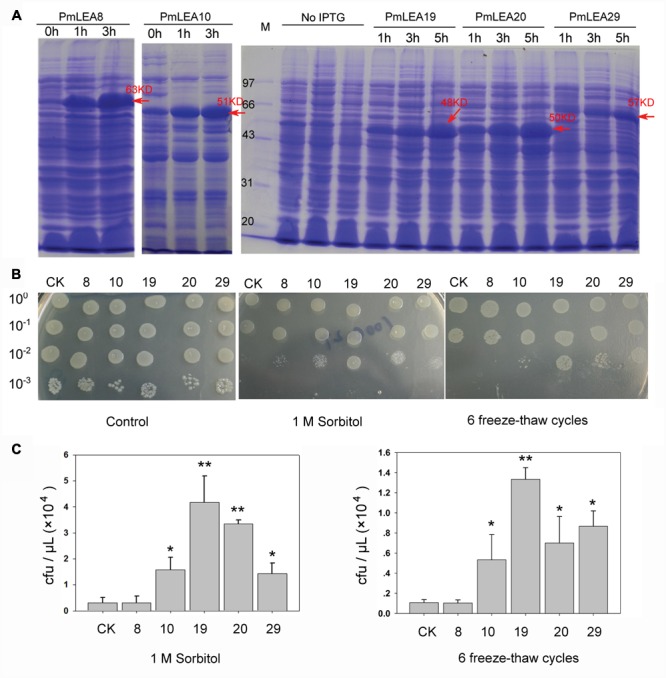
The prokaryotic expression of proteins PmLEAs and growth performance of E.coli under sorbitol or freeze-thaw cycles treatments. (A) SDS-PAGE analysis of prokaryotic expression product for PmLEAs without IPTG induction (0 h) or subjected to different time of IPTG induction (1 – 5 h). Arrows indicate presence of the induced protein at the expected size. (B) The growth performance of E. coli BL21(DE3)/pDEST-PmLEAs on LB plate (left), LB plate with 1M sorbitol (middle) and on LB plate after 6 freeze-thaw cycles (right). CK: BL(DE3)/pDEST15-GUS, 8: BL21(DE3)/pDEST-PmLEA8, 10: BL21(DE3)/pDEST-PmLEA10, 19: BL21(DE3)/pDEST-PmLEA19, 20: BL21(DE3)/pDEST-PmLEA20, 29: BL21(DE3)/pDEST-PmLEA29. The cell cultures were adjusted to OD600 = 0.6, and then diluted serially (1:10, 1:100, and 1:1000, respectively). Five microliter of each sample was spotted onto the LB plates containing 1 mM IPTG. (C) The statistical analysis of bacterial colonies after different treatments, as shown in above. The data are presented as the mean values of three replicates ± SD. ∗, 0.01 < P < 0.05; ∗∗, P < 0.01 (Student’s t-test). Three independent experiments were performed and gave similar results.